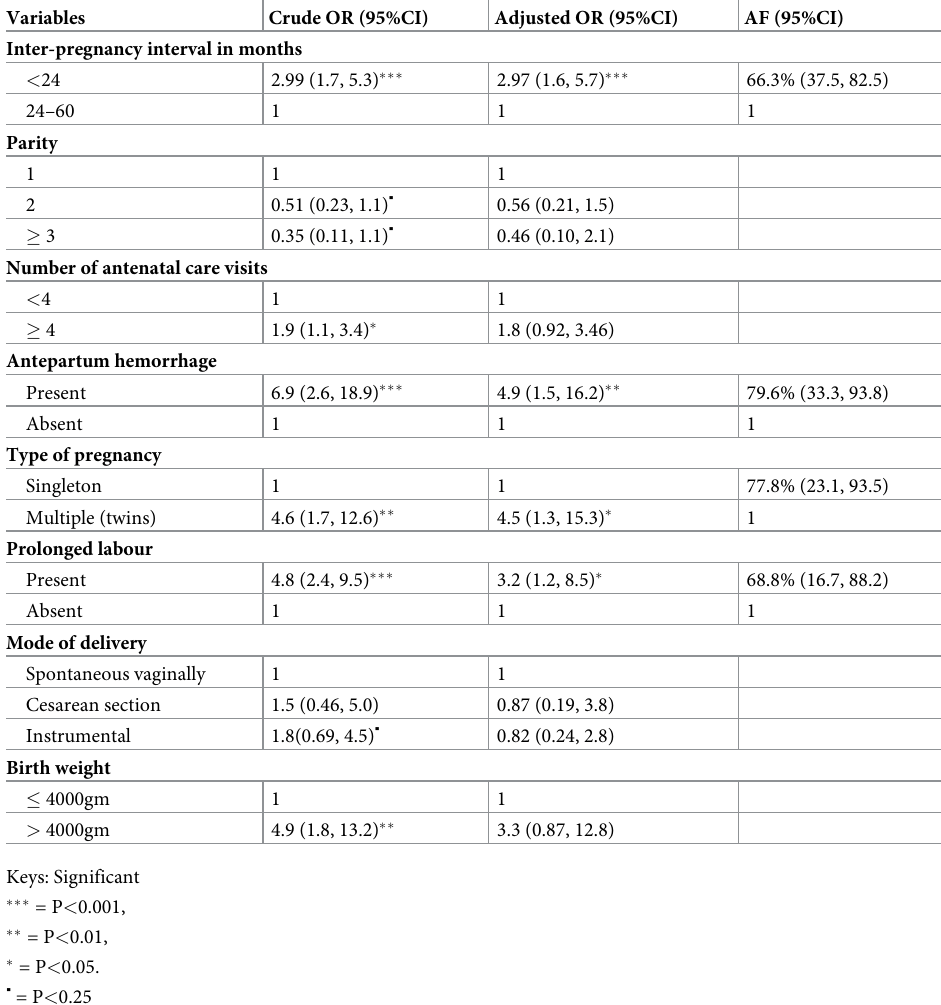
Table 3. Multivariable conditional logistic regression model for the association of primary postpartum hemor- rhage with the inter-pregnancy interval in urban South Ethiopia, July 2019-September